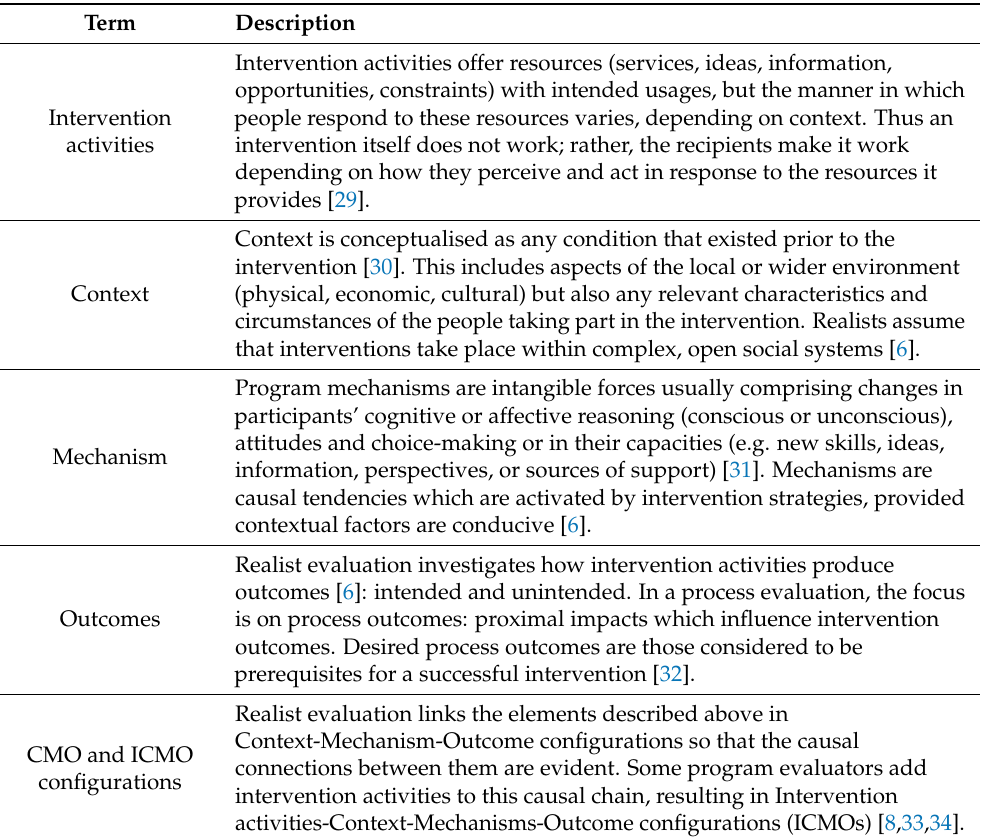
Table 1. Glossary of realist